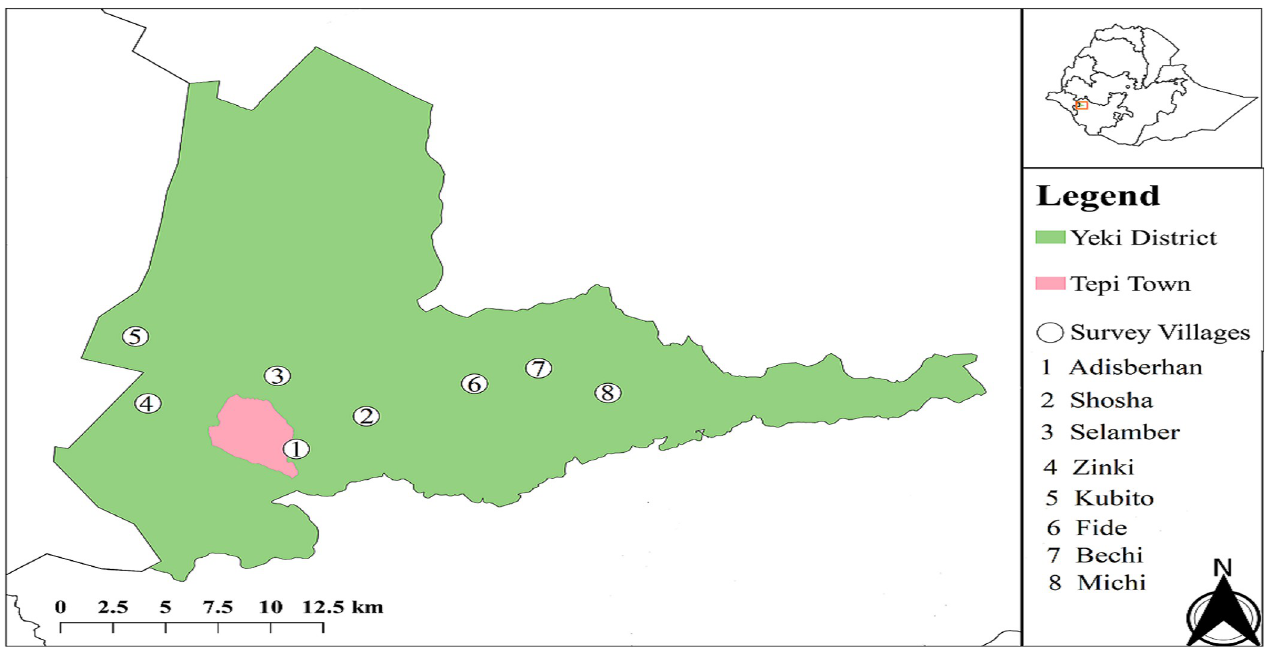
Fig 1. Study map showing study kebeles (the smallest administrative unit) in Yeki district of SNNPR, southwest Ethiopia. QGIS version 3.10, a free and open source GIS software, was used to generate the map of the study area [38]. The spatial data referring to the study sites are acquired using a handheld GPS device (Garmin’s GPSMAP 60CSx, Garmin International Inc., Olathe, Kansas, USA) during sample collection. The administrative spatial data (Open Street Map shapefile) used to prepare this study map was downloaded from GADM (https://gadm.org/download_country_v3.html), which is free and open source database of global administrative